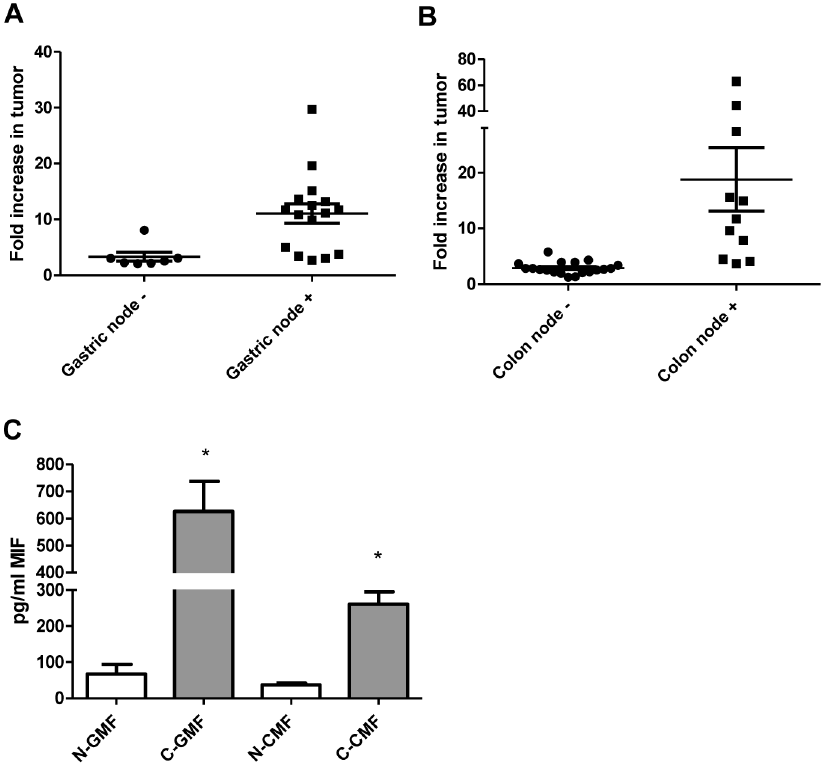
Figure 1. MIF is highly expressed in gastric and colon tumors and human tissue-derived fibroblasts. MIF mRNA levels measured by qRT PCR are increased in A) human gastric tumor samples and at higher levels in tissues from patients with nodal involvement, B) human colon tumor samples and at higher levels in tissues from patients with nodal involvement, and C) in the supernatants tumor derived gastric and colon fibroblasts compared to matched normal as measured by Luminex singleplex assay. N=8 for C and the mean 6 standard error are shown as the results of duplicated in multiple experiments. * p , 0.05.